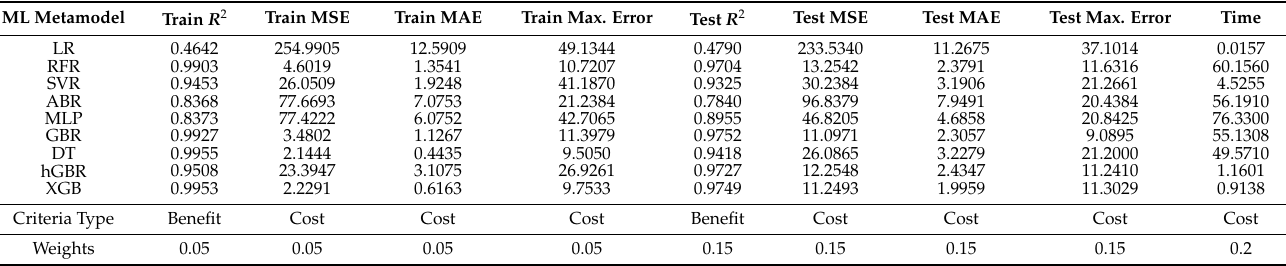
Table 4. Initial decision matrix for TOPSIS.